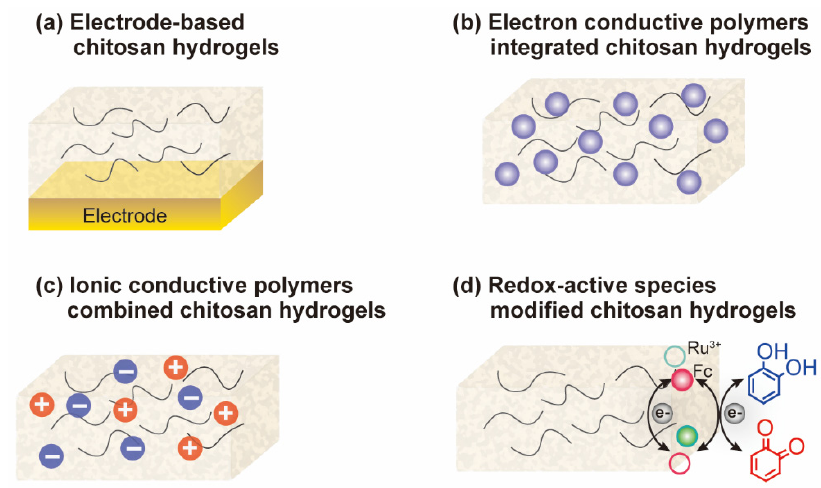
Figure 2. Chitosan-based hydrogels. ( a ) Electrode-based chitosan hydrogels. ( b ) Electron conductive polymers integrated chitosan hydrogels. ( c ) Ionic conductive polymers combined chitosan hydrogels. ( d ) Redox-active species modified chitosan hydrogels.